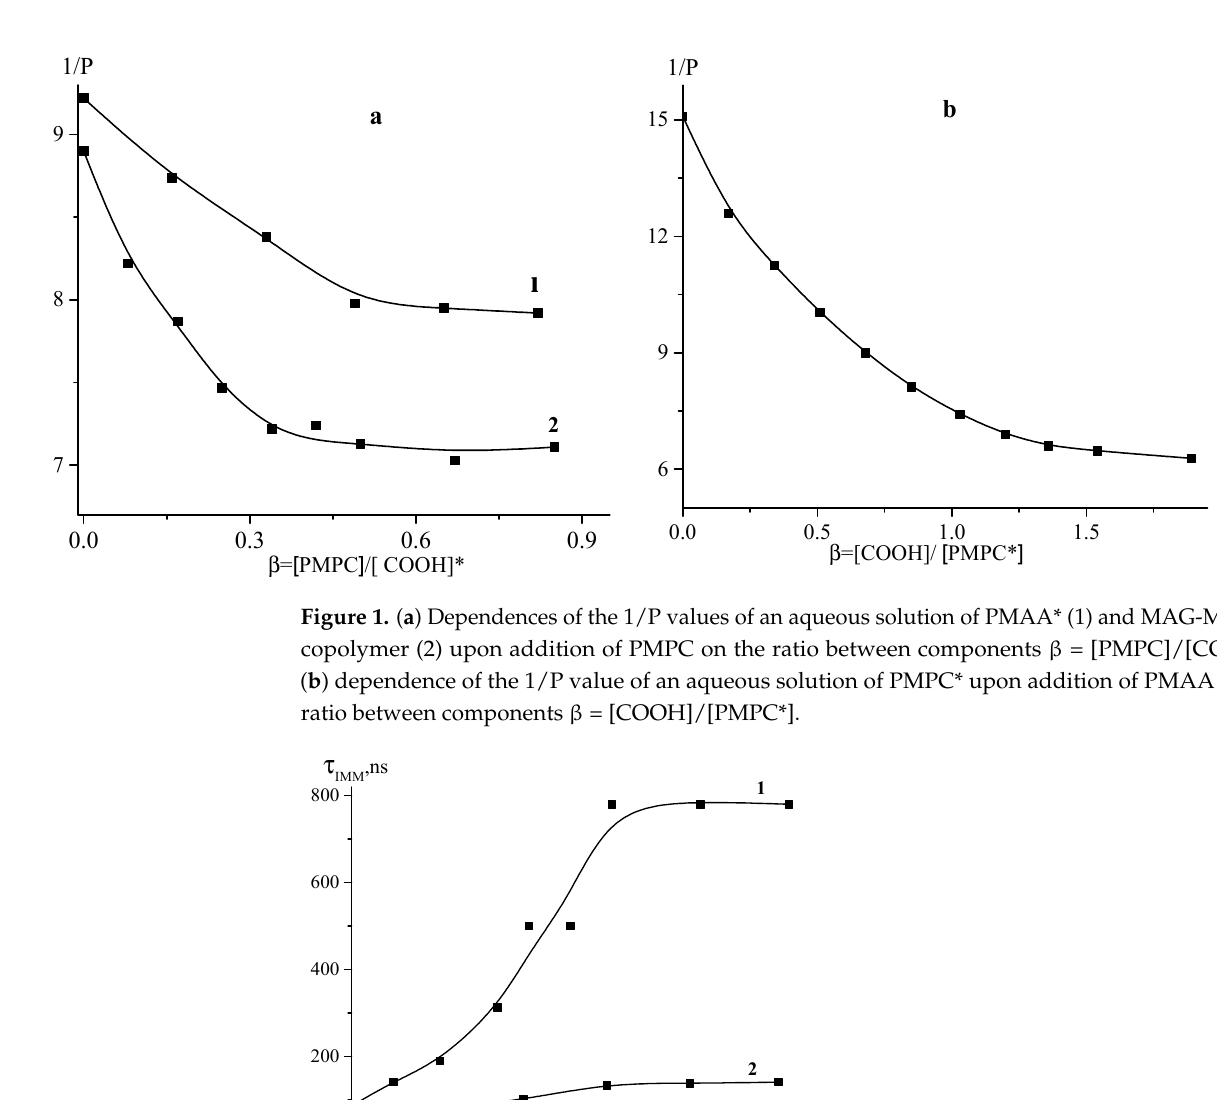
Figure 1. ( а ) Dependences of the 1/ Р values of an aqueous solution of PMAA* (1) and MAG-MAA 70 * copolymer (2) upon addition of PMPC on the ratio between components β = [PMPC]/[ СООН *]; ( b ) dependence of the 1/ Р value of an aqueous solution of PMPC* upon addition of PMAA on the ratio between components β = [COOH]/[PMPC*].